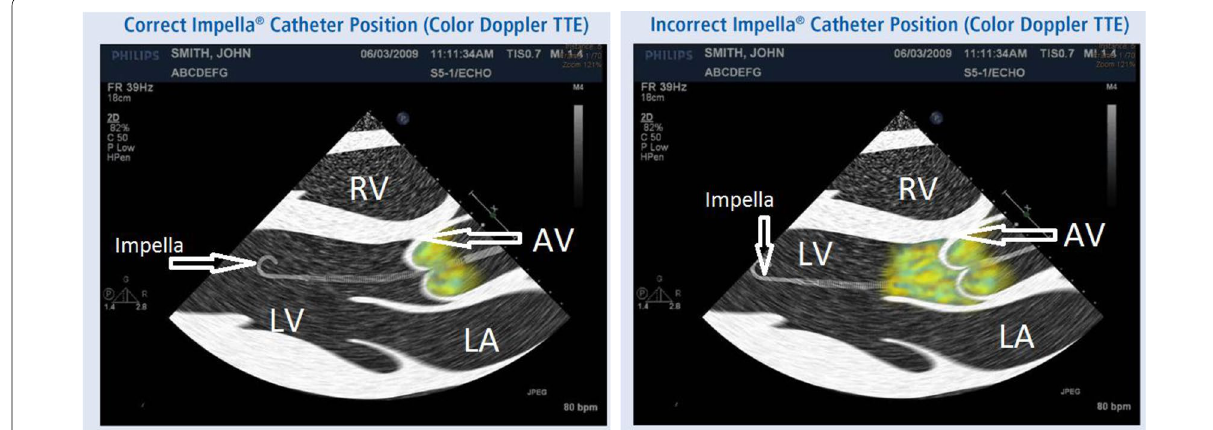
Fig. 1 Illustration showing incorrect and correct positioning of Impella ® with color flow. Parasternal long-axis view on transthoracic echo (Illustra- tion). In the incorrectly positioned Impella ® , the outflow is seen below the aortic valve. The catheter is also located too deep in the left ventricle compared to a correctly placed catheter. AV aortic valve, LV left ventricle, LA left atrium, RV right ventricle. Image reproduced with permission from Abiomed Corporation